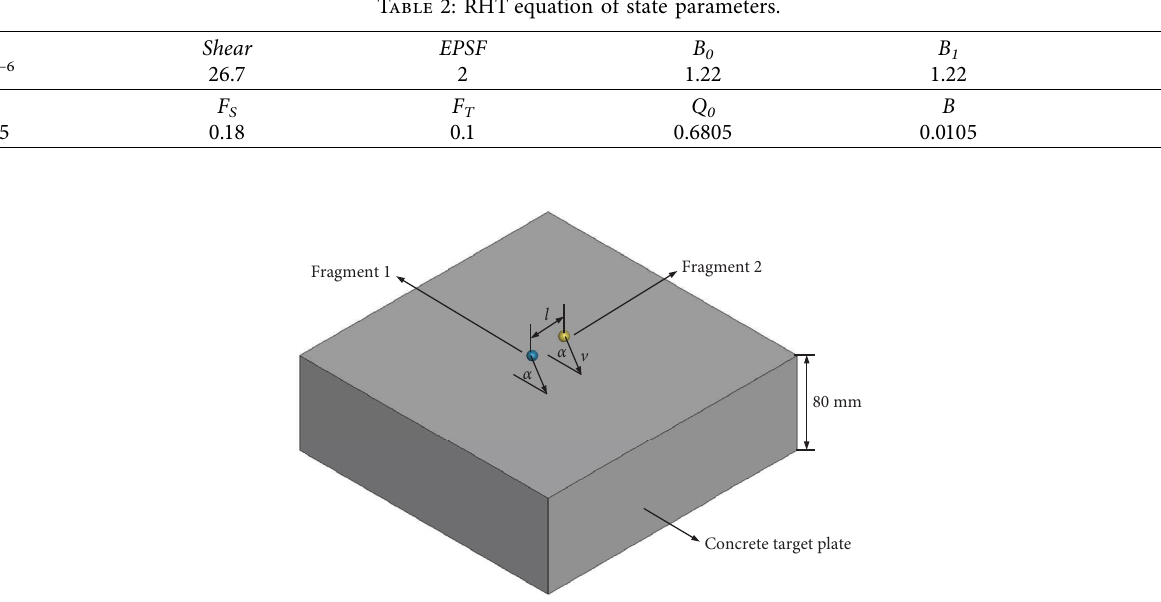
Figure 1: Modeling of double fragment penetration in coplanar. Table 3: Coplanar double fragment orthogonal optimization of four variable three-level